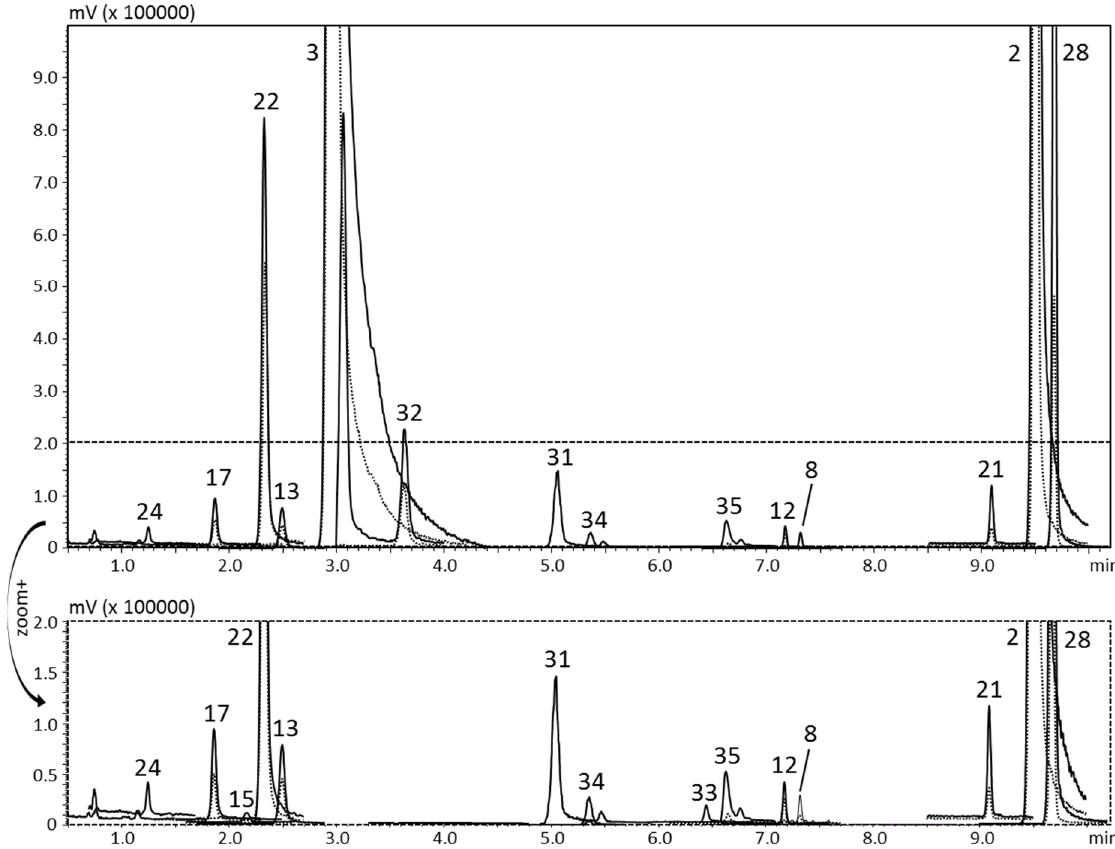
Figure 2. HPLC-MS/MS (MRM acquisition mode) chromatogram of the bergamot juice. Quantifier ion, continuous line; qualifier ion, dotted line. For peak identification see Table 2.